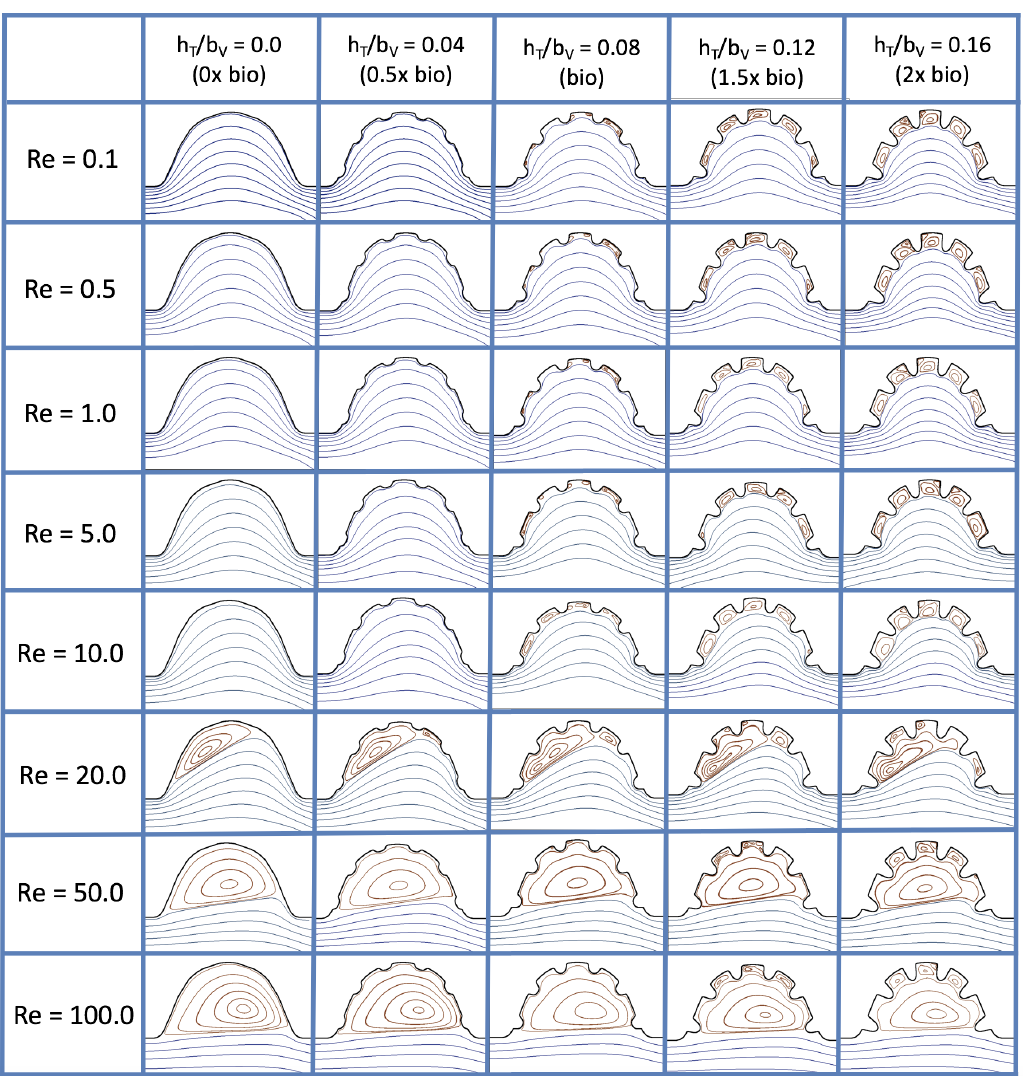
Figure 16. Streamline analysis performed for the case of steady flow into the trabeculated ventricle of a zebrafish at 4 dpf for varying Re and trabeculae